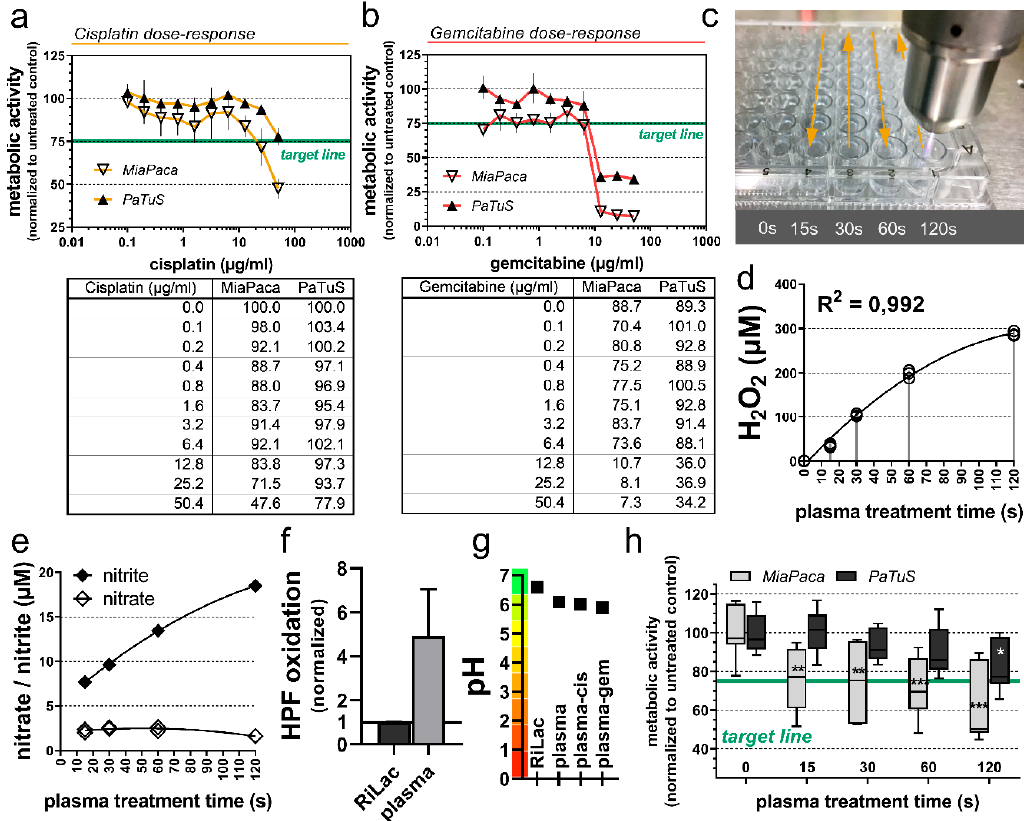
Figure 1. Dose-depended inactivation of pancreatic cancer cells through the application of cisplatin, gemcitabine, or physical plasma-conditioned Ringer’s lactate. ( a , b ) the metabolic activity of MiaPaca and PaTuS pancreatic cancer cells 24 h post-exposure to ( a ) cisplatin and ( b ) gemcitabine IC-25 target-line (green); ( c ) schematic overview of the standardized exposure of 100 µ L Ringer’s lactate to the e ffl uent of a kINPen argon plasma jet for 0, 15, 30, 60, and 120 s, and ( d ) the amount of hydrogen peroxide (H 2 O 2 ) generated in this liquid; ( e ) metabolic activity of MiaPaca and PaTuS pancreatic cancer cells 24 h post-exposure to the respective physical plasma-conditioned Ringer’s lactate. Data are ( a , b ) mean ± SD and are representatives out of three independent experiments, ( d ) individual technical replicates with curve fitting of a quadratic function (R 2 = 0.992) from three technical replicates; ( e ) concentration of nitrate and nitrite in plasma-conditioned liquid; ( f ) oxidation of hydroxyphenyl fluorescein (HPF) in Ringer’s lactate through 120 s of plasma-treatment; ( g ) pH value of 120 s plasma-conditioned Ringer’s lactate and plasma in combination with cisplatin and gemcitabine; ( h ) metabolic activity of pancreatic cancer cells with IC-25 target-line (green) 24 h post-exposure to physical plasma-conditioned Ringer’s lactate as representative out of three independent experiments showing median and min to max. Statistical significance was calculated utilizing ANOVA. Table 1. Concentration of adjuvant chemotherapy (CTx) and plasma-conditioned Ringer’s lactate used in this